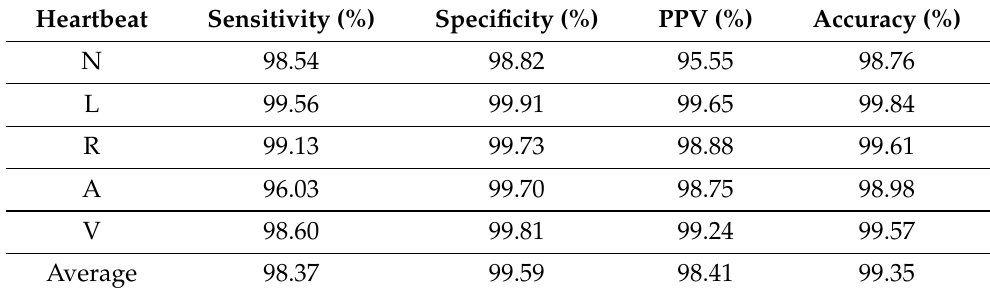
Table 12. Evaluation of Performance Metrics on D2.